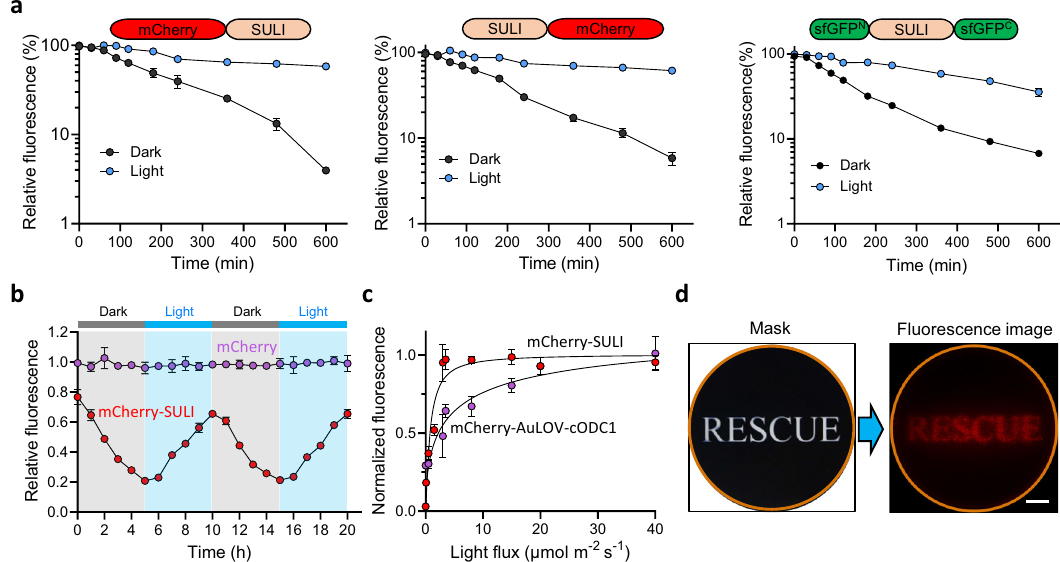
Fig. 3 | Kinetics characteristics of SULI. a Degradation kinetics of SULI-regulated protein stability. Yeast cells expressing different SULI fusion proteins cultured upon light illumination were then incubated with CHX and transferred to dark conditionsorkeptinlightconditions.The fl uorescenceofthefusionproteinsatthe indicatedtimepointswasrecordedby fl owcytometry.Thedatawerenormalizedto the fl uorescenceattime0min. b OscillatorycontrolofproteinabundancebySULI. Yeast cells expressing mCherry-SULI were cultured alternatively in light and dark withanintervalof5hforatotalof20h.mCherry fl uorescenceattheindicatedtime points was measured using a microplate reader. The data were normalized to the data for the cells expressing mCherry alone at each indicated time point. The data